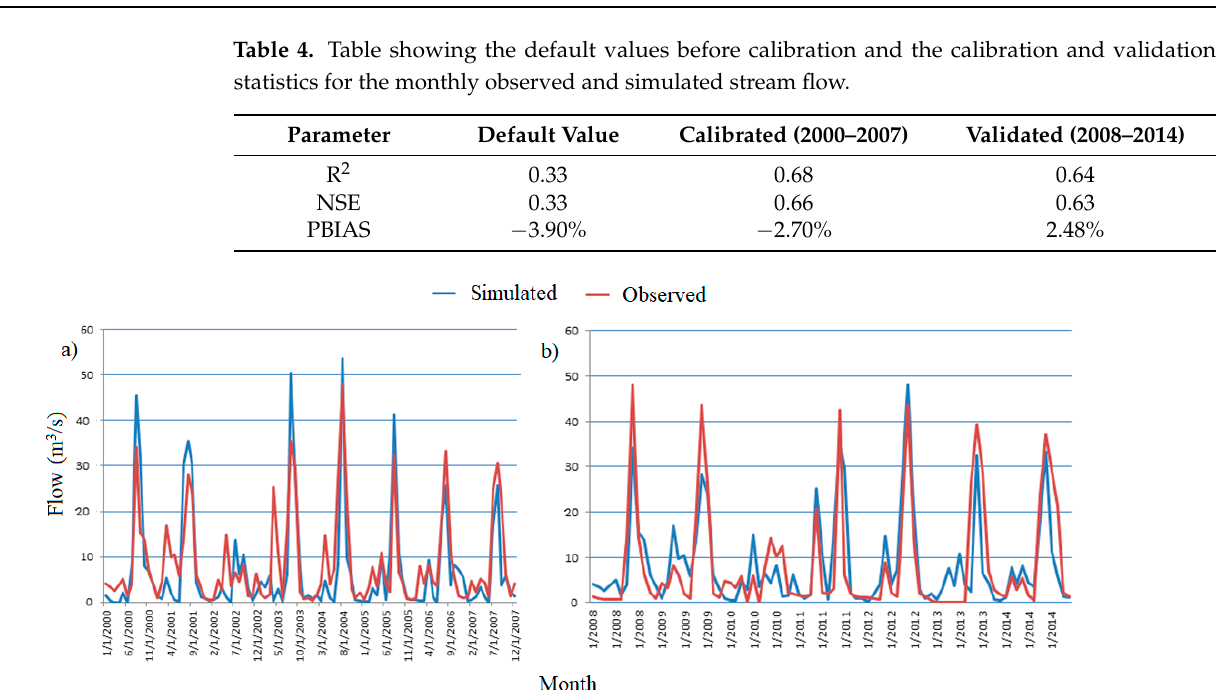
Figure 3. Monthly observed and simulated stream flow: ( a ) Calibration period, ( b ) validation period